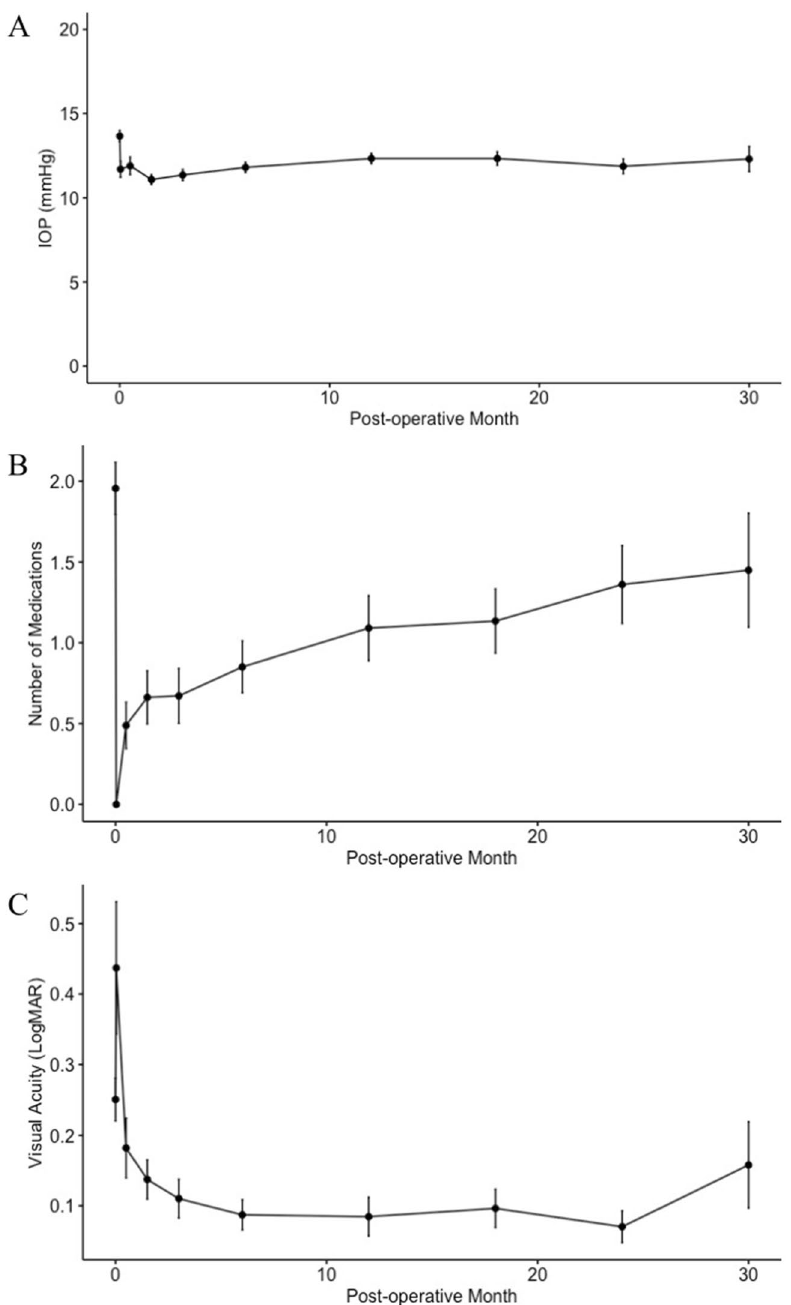
Figure 1. Line graphs of average values of postoperative ( A ) intraocular pressure, ( B ) number of medications, and ( C ) visual acuity over time. Error bars denote standard